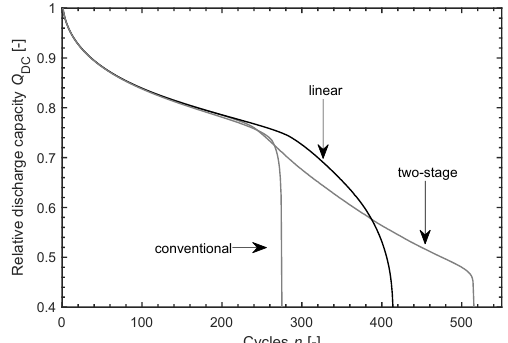
Figure 7. Discharge capacity relative to initial capacity for the cell with linearly increasing anode porosity. This design shows the highest discharge capacity until cycle n = 400 and unlike the other results it doesn’t show a distinct sudden-death. The previous designs are shown in grey as